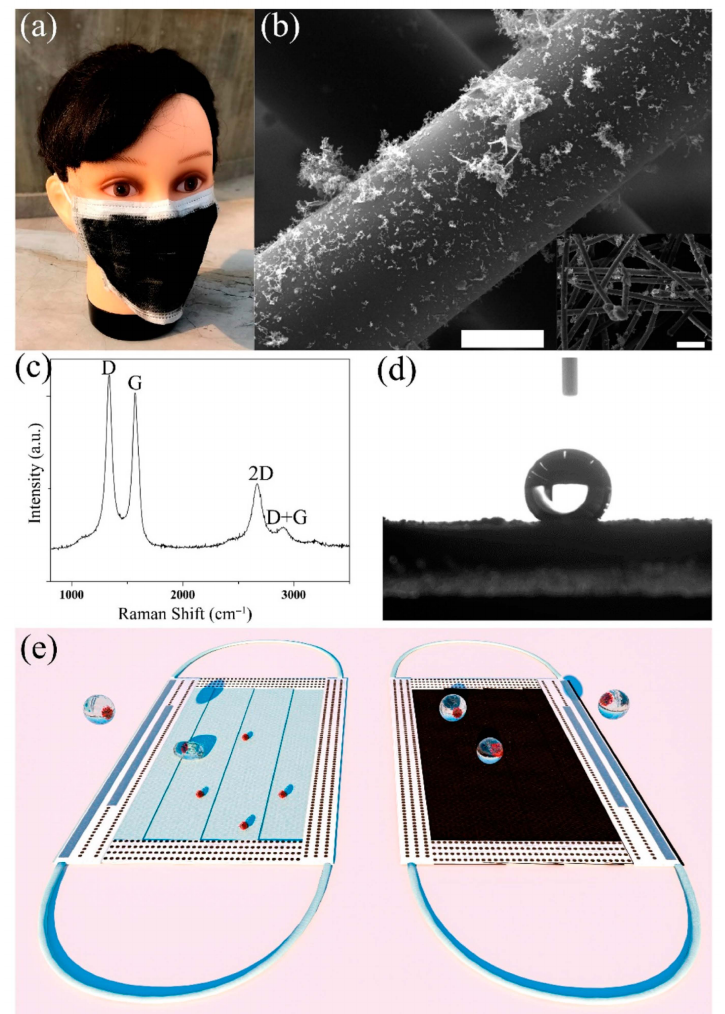
Figure 5. ( a ) Optical image of the laser-fabricated graphene mask. ( b ) SEM of the graphene-coated nonwoven fiber within the surgical mask; scale bar is 10 µ m. The inset is a zoom-out image, with the scale bar at 100 µ m. ( c ) Raman spectrum of the graphene-coated mask. ( d ) Water contact angle on the graphene-coated mask. ( e ) Illustration of the self-cleaning properties of the black graphene-coated mask ( right ), compared to the pristine blue mask ( left ). (Reproduced with permission from Ref.